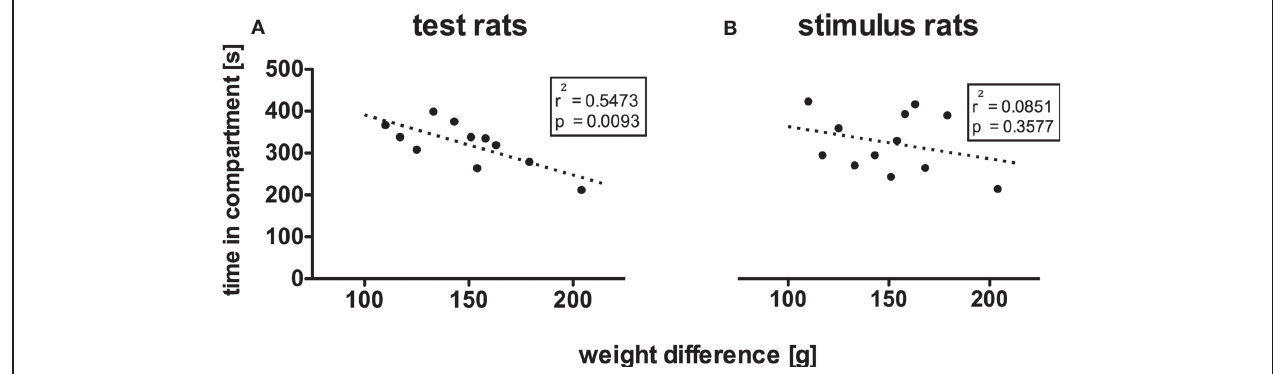
FIGURE 2 | Weight difference decreases social interaction CPP more in test rats than in stimulus rats. Pearson’s correlation of weight difference and time spent in the interaction-paired chamber yielded a significant negative correlation ( r 2 = 0 . 5473, p = 0 . 0093) for test rats (A) , and no statistically significant correlation for stimulus rats (B)